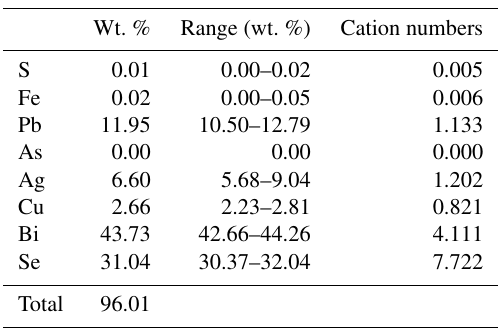
Table 1. Electron-microprobe analysis of luxembourgite. Wt. % Range (wt.